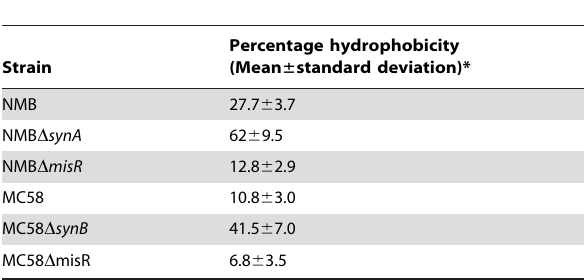
Table 5. Adhesion of bacterial strains to hexadecane in the MATS